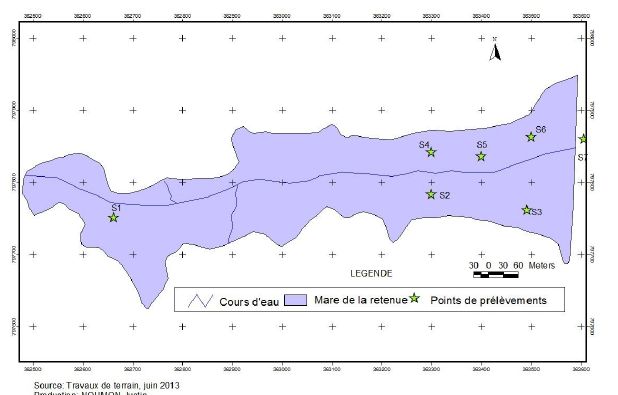
Figure A1. Carte de situation de points échantillons pour les ana- lyses de qualité de